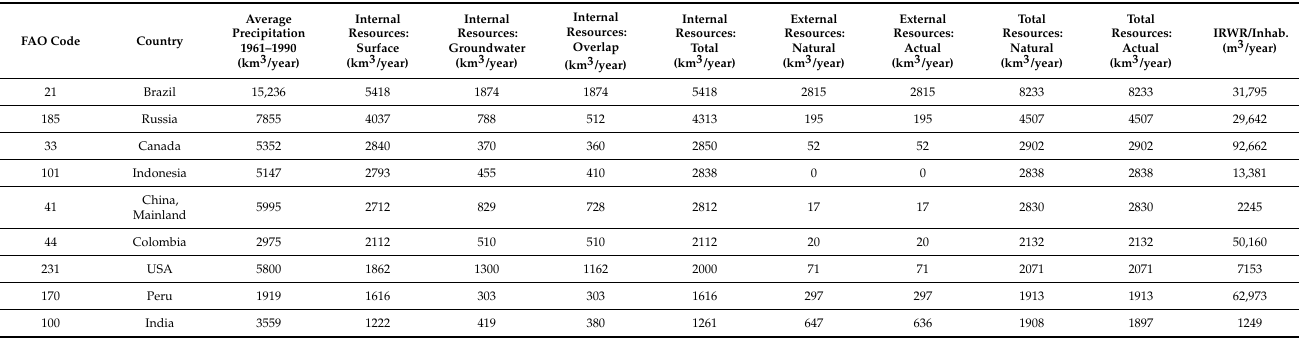
Table 1. Countries according to the drinking water